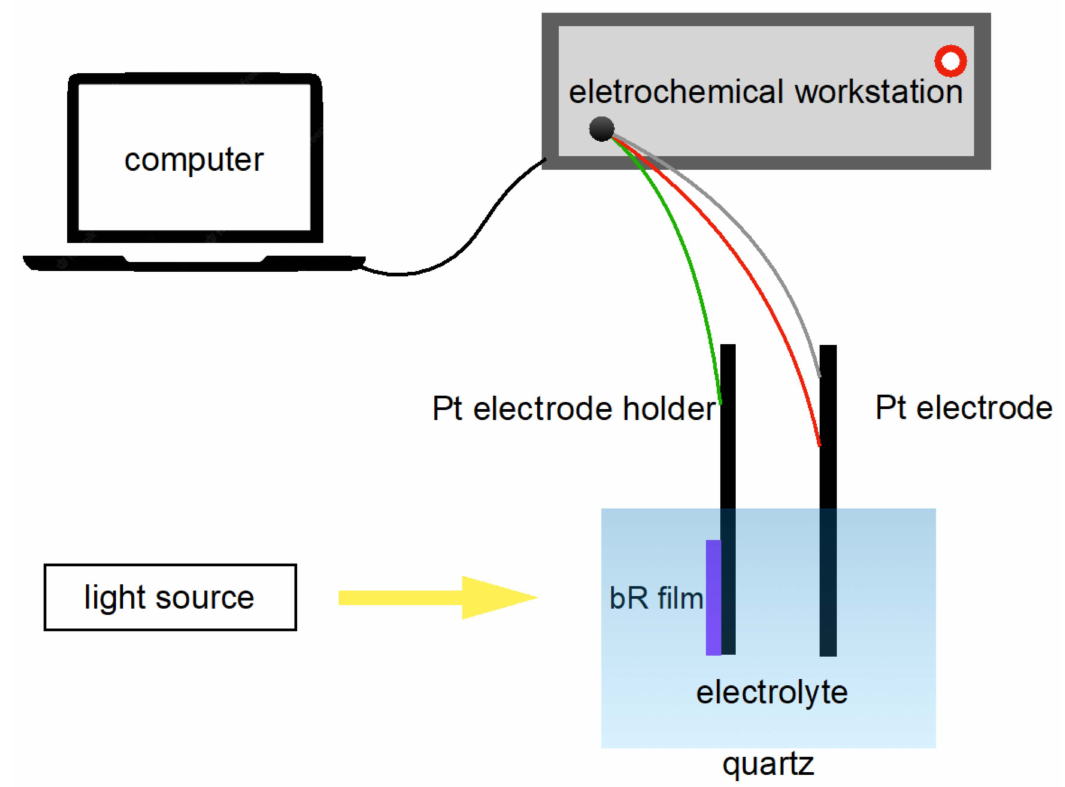
Figure 5. Schematics of the photocurrent measurement apparatus. The bR film initiates its proton pumping function under light stimulation, generating a photocurrent which is then detected by the electrochemical workstation and recorded by the